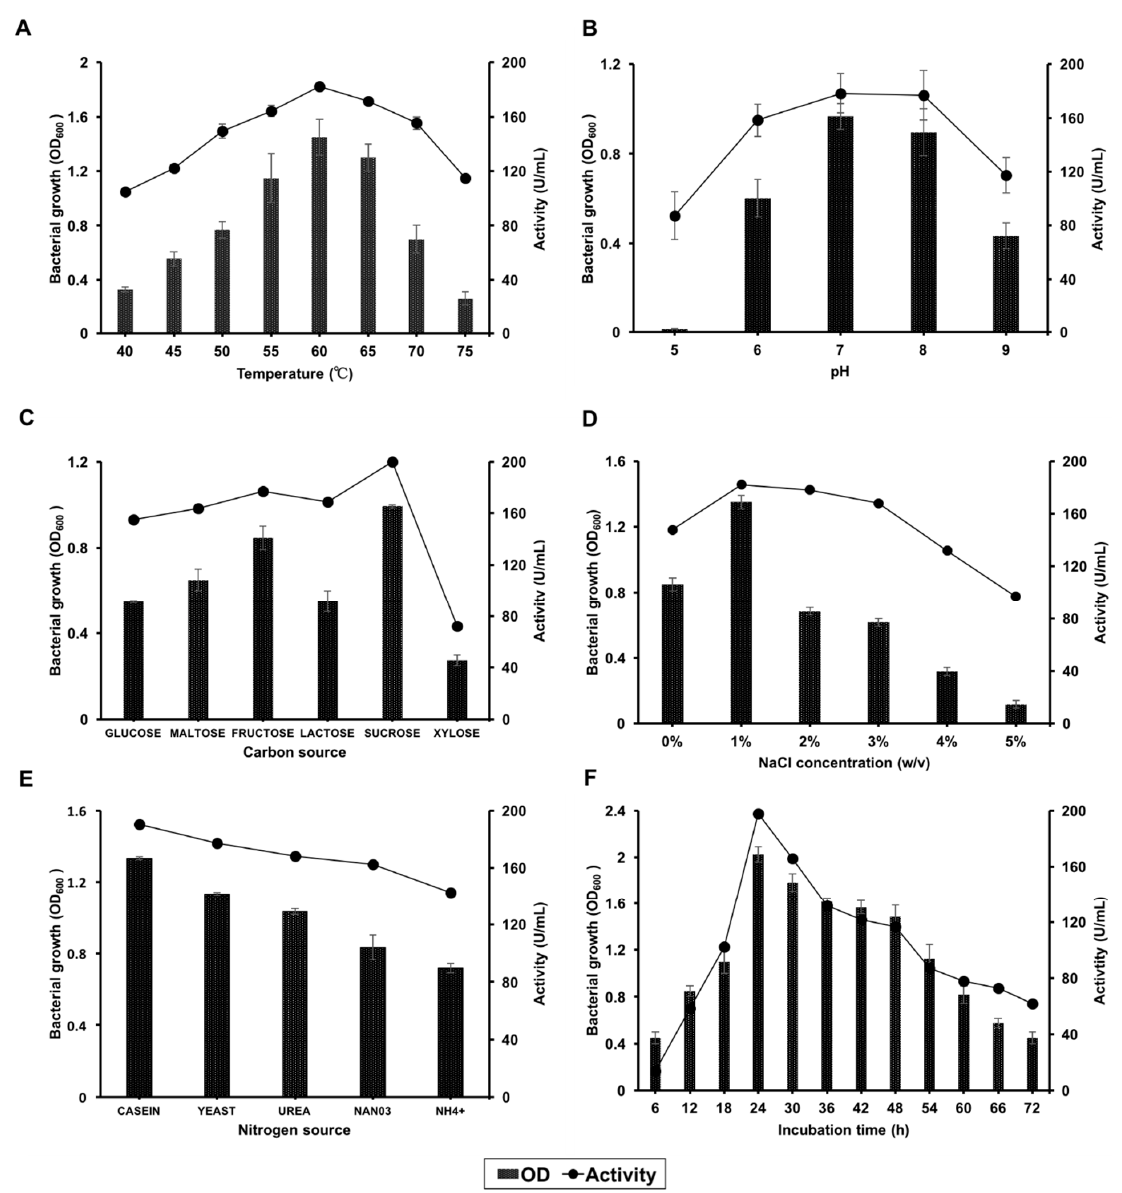
Figure 4. Effects of ( A ) temperature, ( B ) pH, ( C ) carbon source, ( D ) NaCl concentration, ( E ) nitrogen source, and ( F ) incubation time on growth and protease production of G. thermoglucosidasius SKF4. Data are expressed as means ( n = 3) ± SDs.